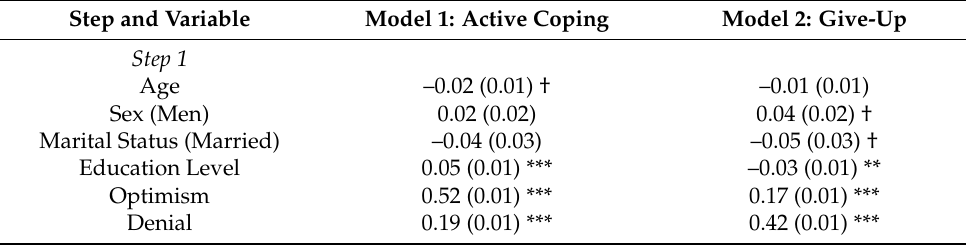
Table 3. Stepwise Regression Results and Model Fit Metrics for Main